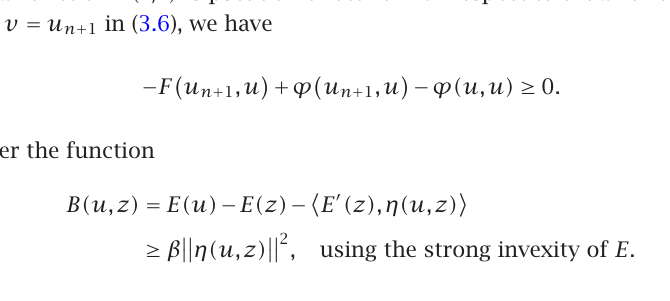
∈ H , calculate the approximate solution u n + 0